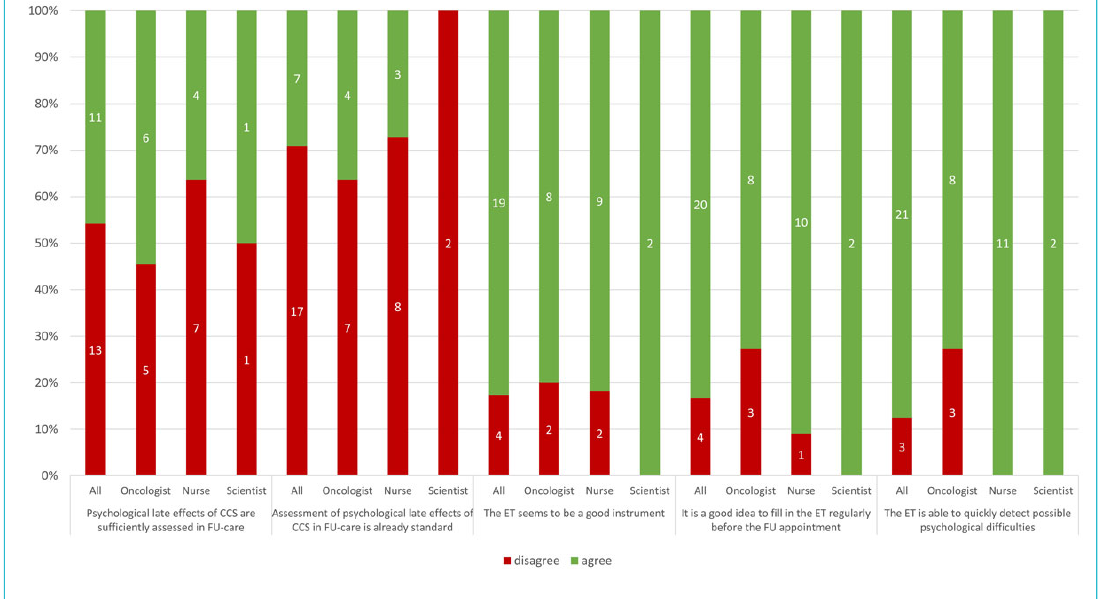
Figure 1: Healthcare professionals’ opinions on the current standard of psychological screening practice in follow-up (FU) care of childhood cancer survivors (CCS) and their perceptions on the emotion thermometer (ET).The values in the bars represent the number of healthcare professionals agreeing or disagreeing with the statements, stratified by profession.